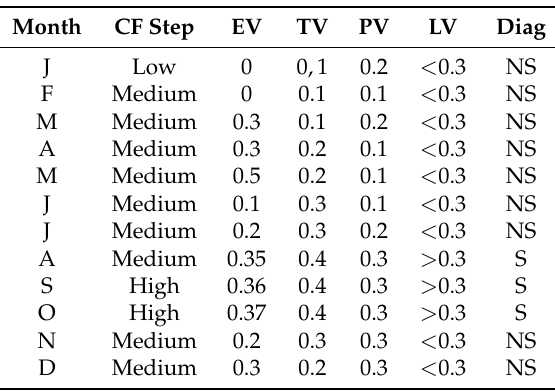
Table 7. Future Consumption Matrix of single-phase CU.